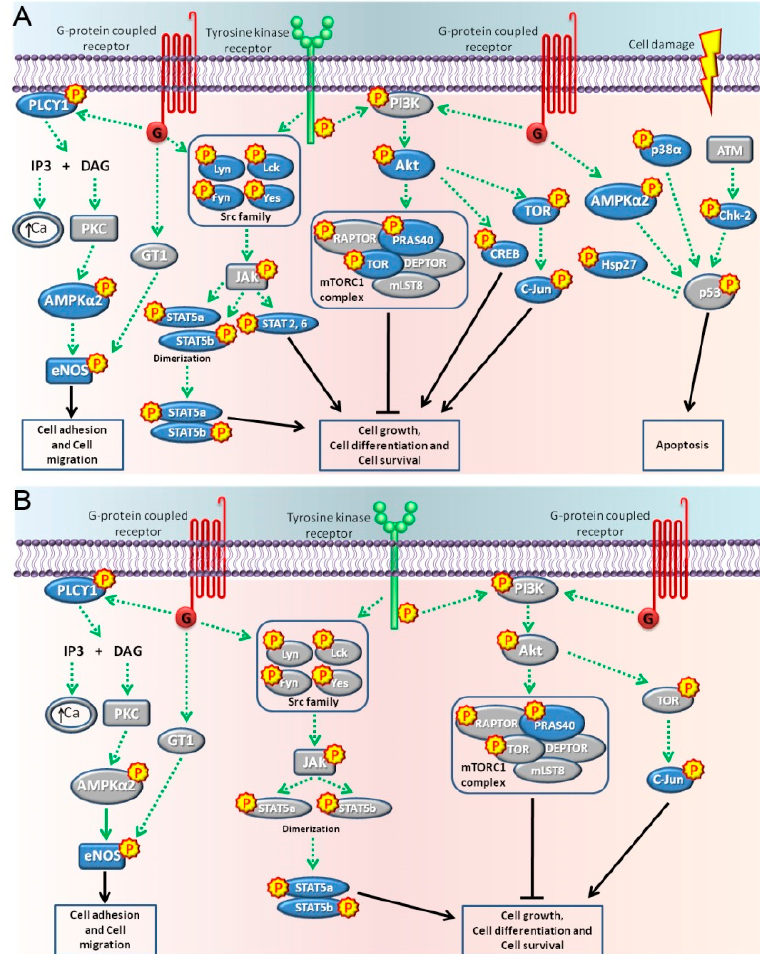
Figure 7. Diagram of possible signaling pathways induced by a 15-min treatment with BPA ( A ) or NP ( B ) in LNCaP cells. BPA mainly activated G protein-coupled membrane receptors and tyrosine kinase receptors or cellular damage pathways ( A ), while NP mainly activated G protein-coupled membrane receptors and tyrosine kinase receptor pathways ( B ). The phosphorylated proteins participating in pathways of: cell adhesion and cell migration, cell growth, cell differentiation and cell survival, and apoptosis. In blue are shown proteins that increase their levels of phosphorylation as a result of the treatment, while in gray are shown proteins that were analyzed did not show a significantly increase in phosphorylation.